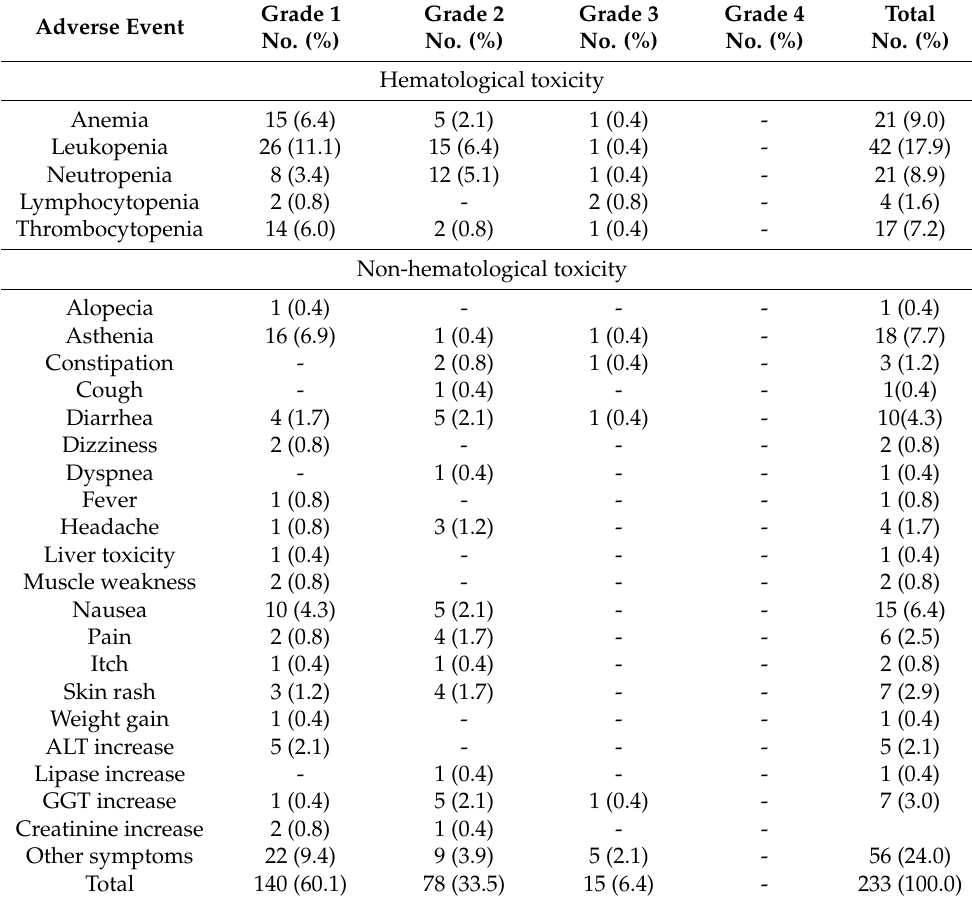
Table 4. Hematological and non-hematological toxicity in patients ( n = 62) with functioning NETs treated with 177